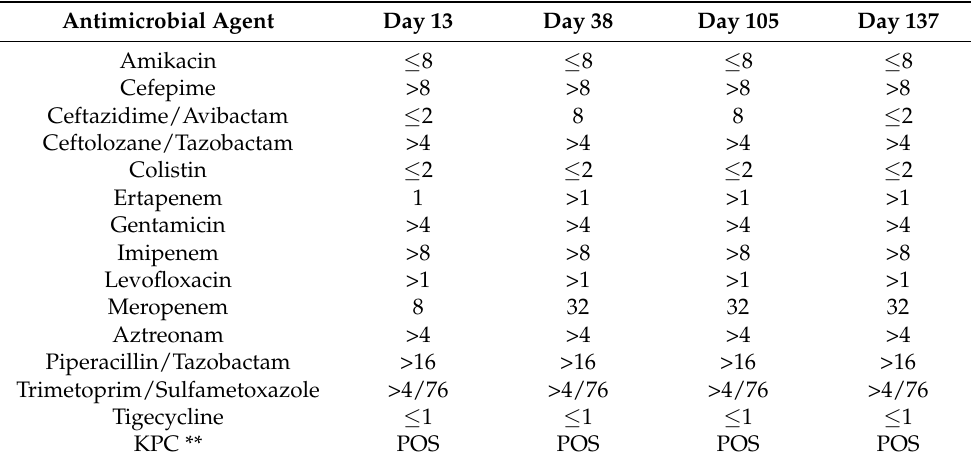
Table 1. Antimicrobial susceptibilities (MIC, μ g/mL *) of serial KPC-Kp blood isolates. Antimicrobial Agent